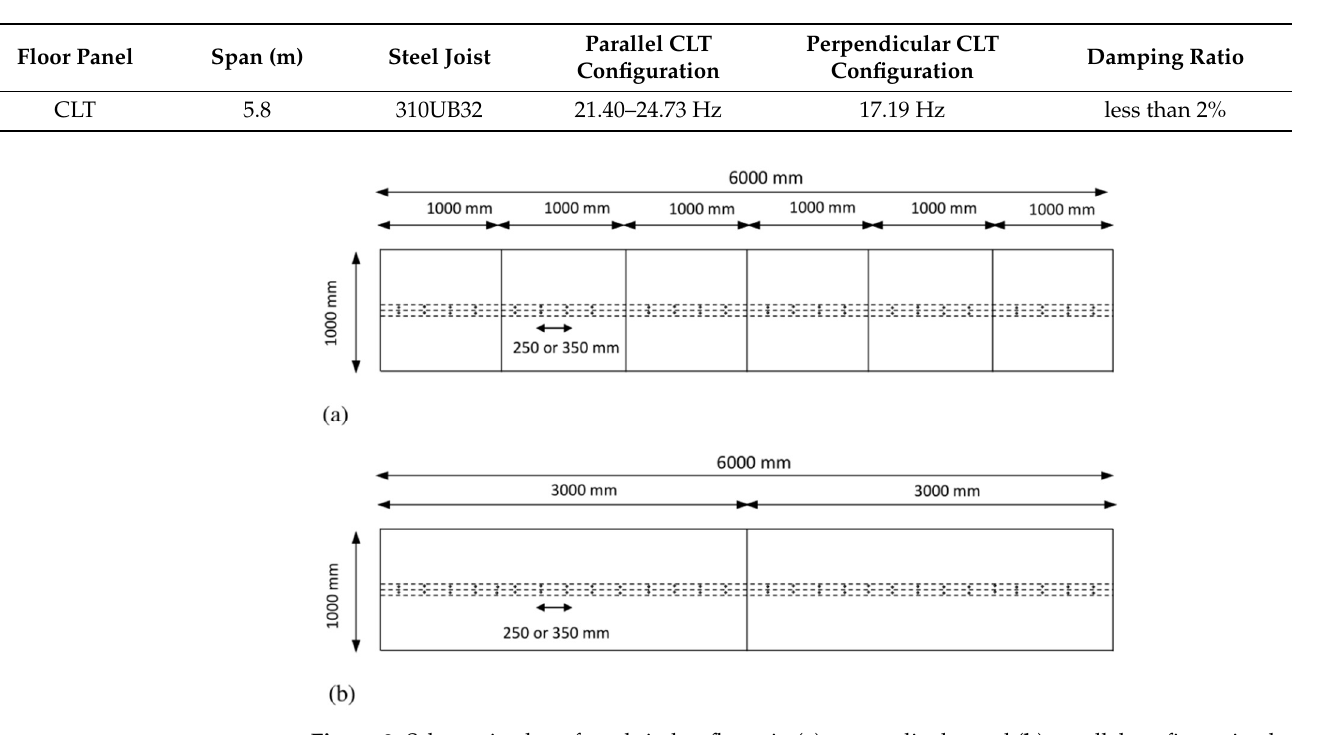
Table 11. Natural frequency (flexural mode) and damping ratio of various STC floors measured by Chiniforush et al. [47]. CLT panels with different shear connectors and configurations were tested.